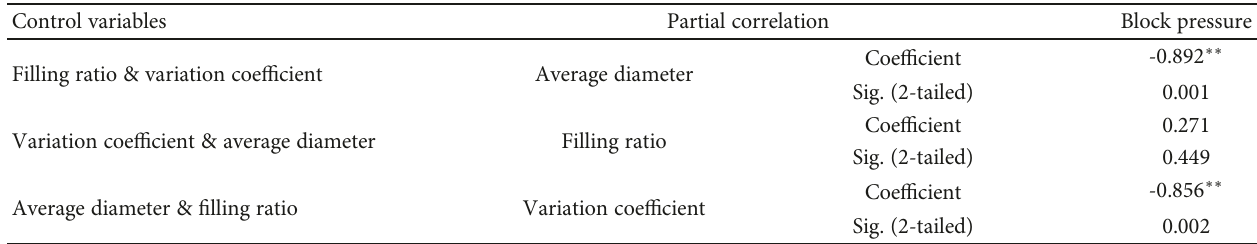
Table 4: Partial correlation between block pressure and texture